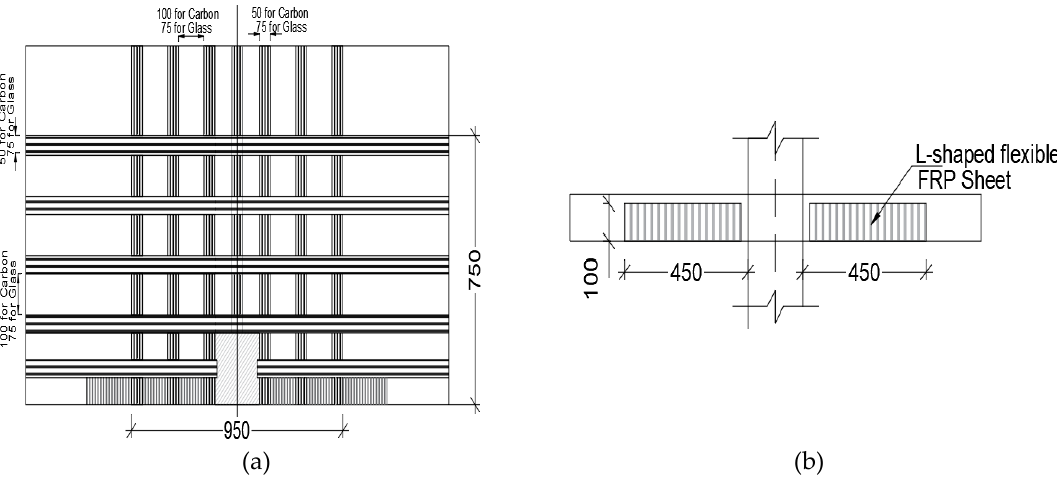
Figure 3. Orthogonal CFRP or glass fiber reinforced polymer (GFRP) strengthening strips for flat slab specimen supported by the edge column: ( a ) extend of strip application and ( b ) extension of strip into L-shape at the end of the slab [28].